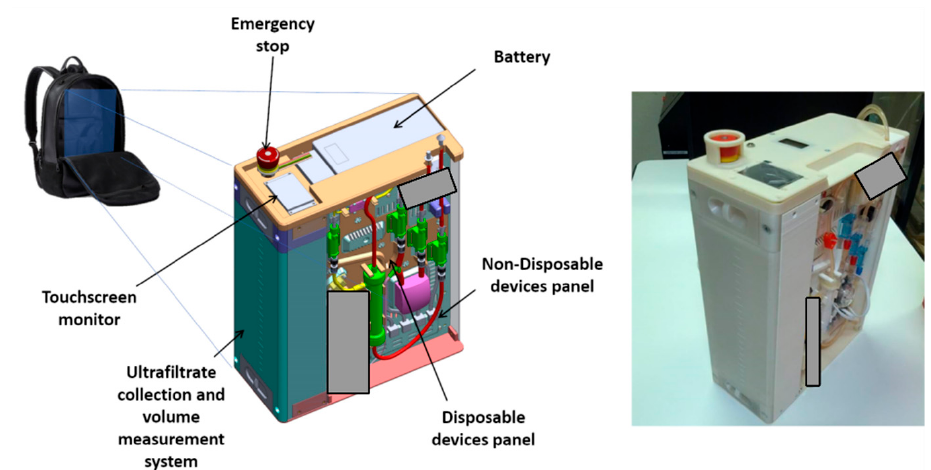
Figure 1. The Rene Artificiale Portatile (RAP) design: 3D sketch and manufactured prototype. Masked sections cover components where patentability is still under investigation at manuscript submission.